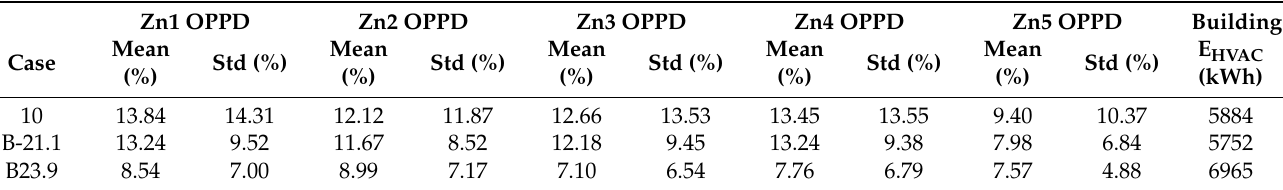
Table 8. The results of multizone testing in the testing building